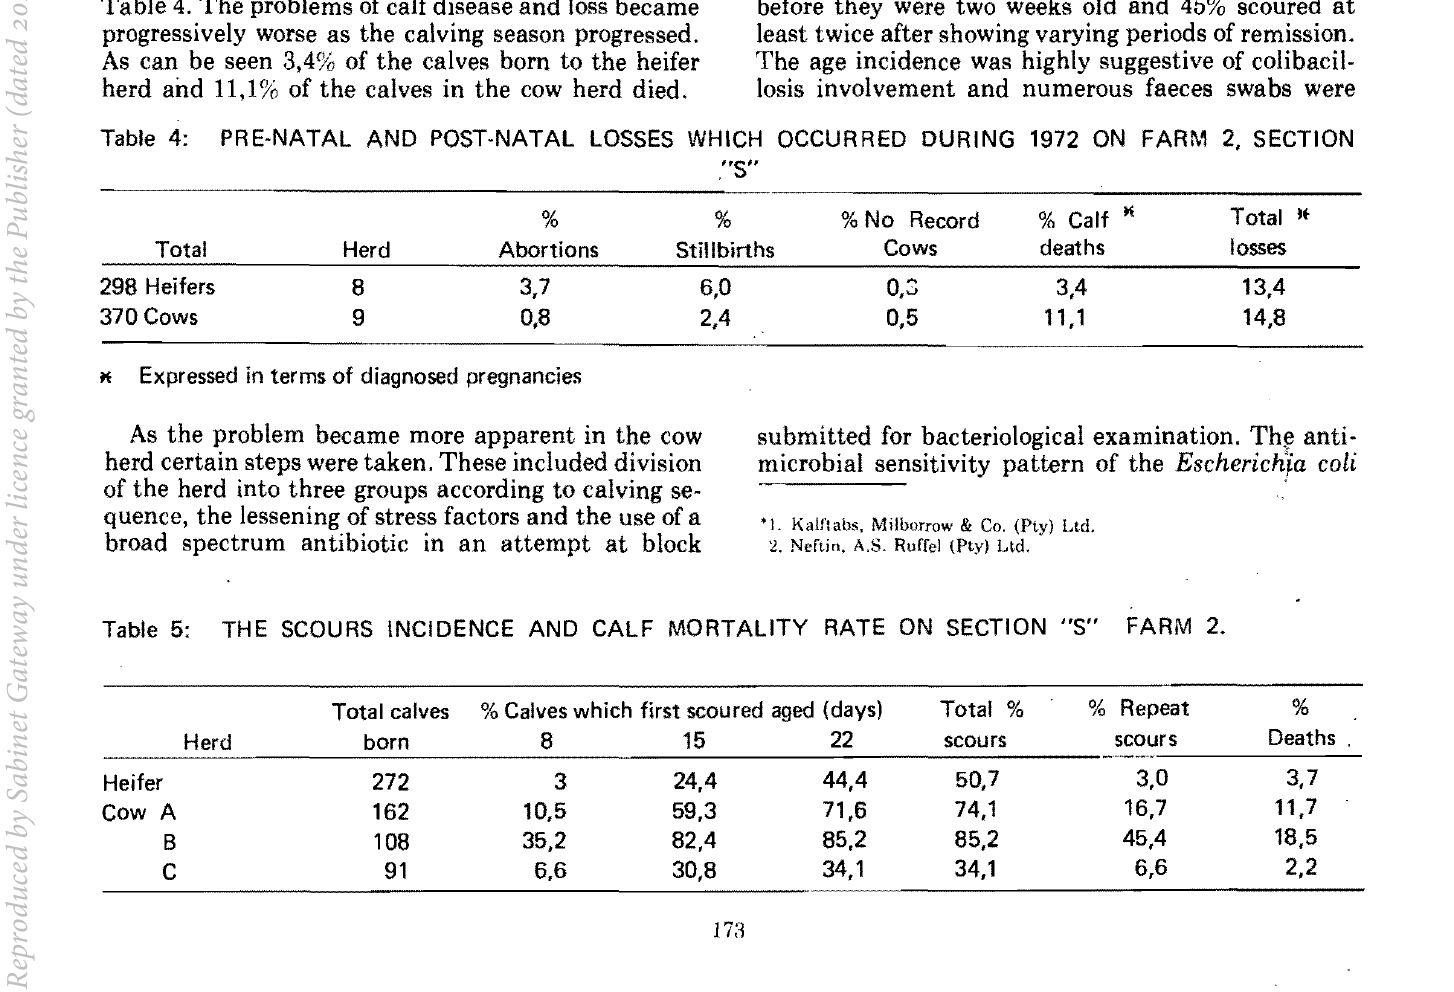
Total calves % Calves which first scoured aged (days) Total % % Repeat Herd